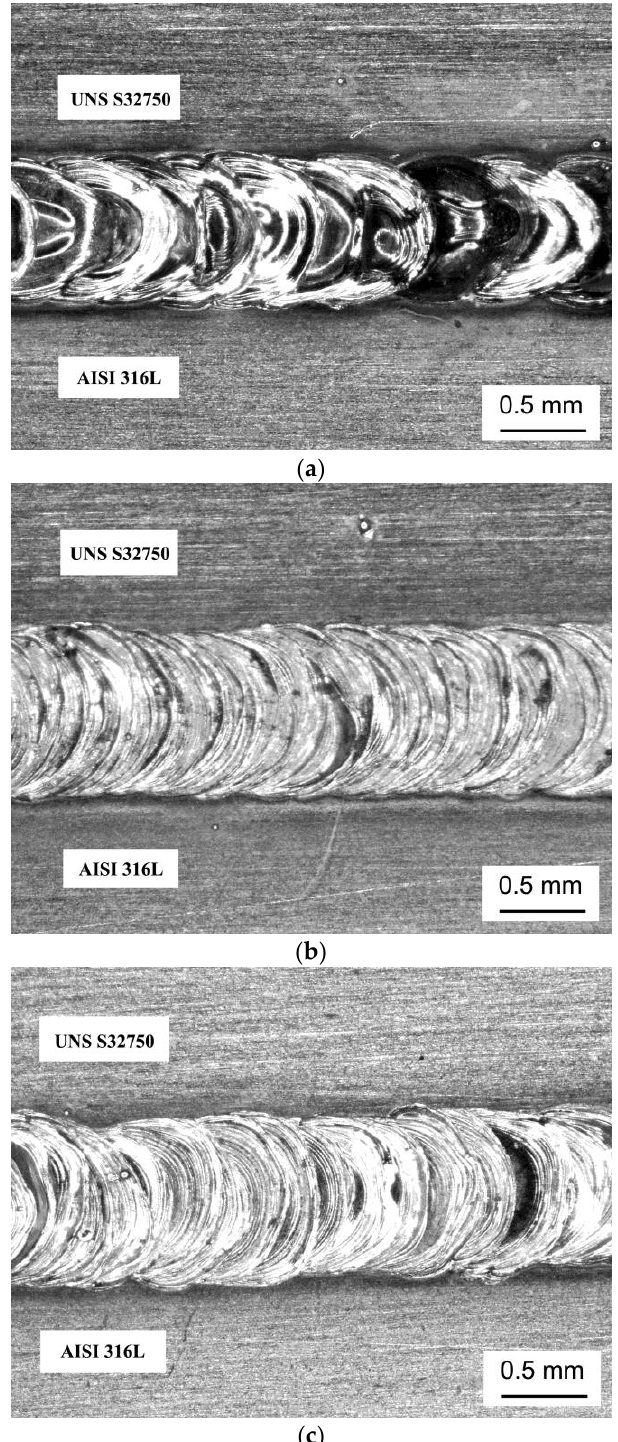
Figure 3. Top view of dissimilar welded specimens with: ( a ) 45 J/mm, ( b ) 90 J/mm and ( c ) 120 J/mm. The microstructures of the transition regions between the base metals, UNS S32750 and AISI 316L, and the fusion zone are shown in Figure 4. In the fusion zone, austenite was formed following three modes: allotriomorphs at the prior-ferrite grain boundaries, Widmanstätten side-plates growing into the grain from the allotriomorphs’ grain boundaries, and intragranular austenite.